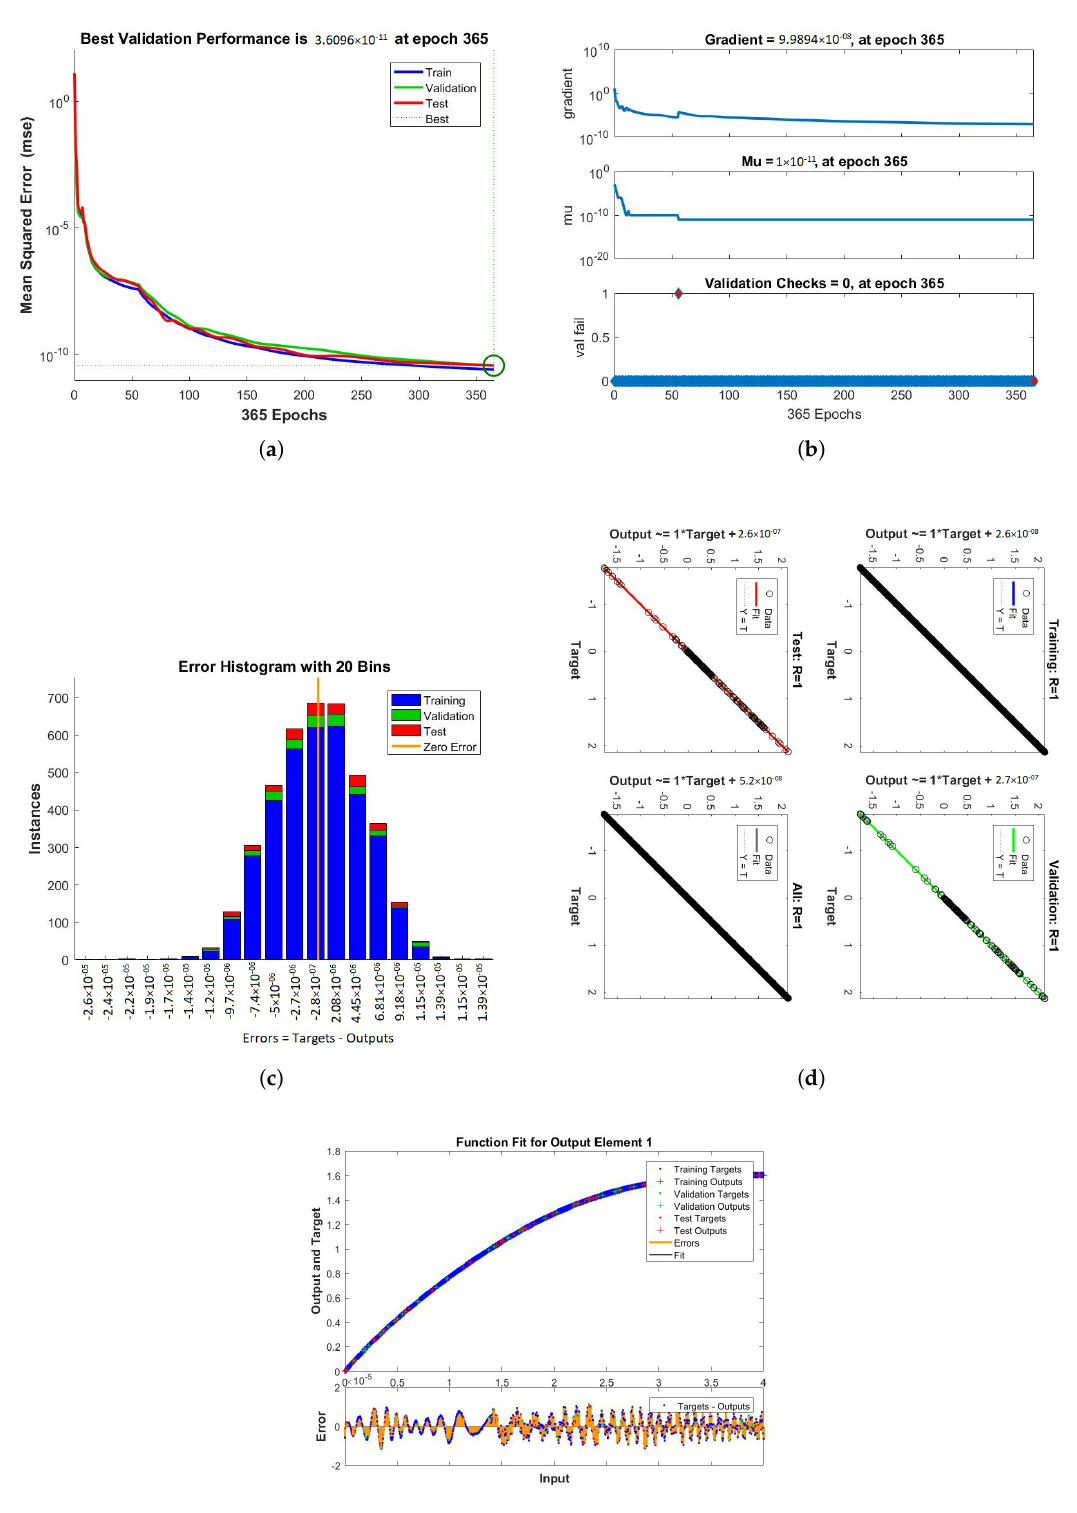
Figure 17. Figures showing the performance, training, error histogram, regression, and fitness graphs of the LMB-NN when value of the volume fraction φ = 0.2. ( a ) Performance. ( b ) Training. ( c ) Error Histogram. ( d ) Regression. ( e )